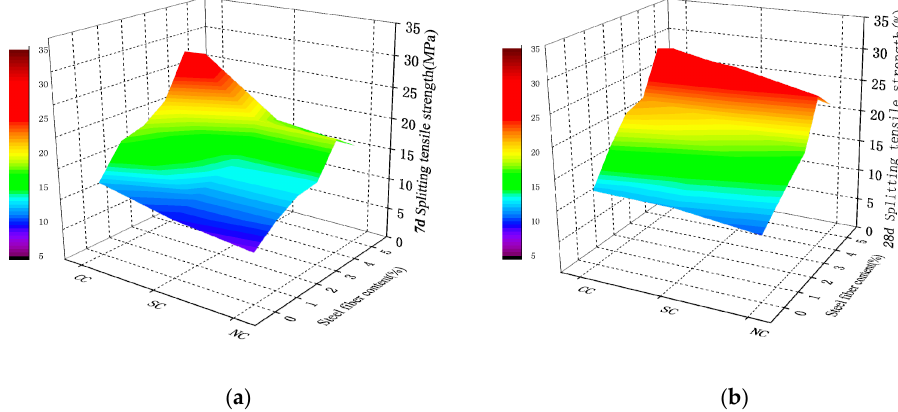
( b ) Figure 11 . Percentage of compressive strength improvement of steel fiber RPC with different dosages of steel fiber after ( a ) 7-day curing and ( b ) 28-day curing. The RPC strength results of various ages under different curing conditions showed that steel fiber positively influences concrete. Seven days before maintenance, when the steel fiber content was 4%, the growth ratio of the compressive and tensile strengths of RPC reached maximum. Hot water curing promotes concrete hydration reaction and ash, and its hydration products make the matrix inside close-grained. The bonding between steel fibers became increasingly dense. Figure 11a demonstrates that RPC compressive strength with the 7-day compound curing rate increased more than those obtained by the other two maintenance methods. When the temperature drops and tends to be stable, the reaction in the RPC matrix slows down. The specimen strength under the standard curing and natural curing conditions gradually increased. However, the compressive strength of the matrix under the three curing conditions increased at a similar rate and stabilized with the progress of the reaction. RPC performance with steel fiber was found to be more stable than that without. Few mutations were observed. This result is helpful for practical engineering applications.